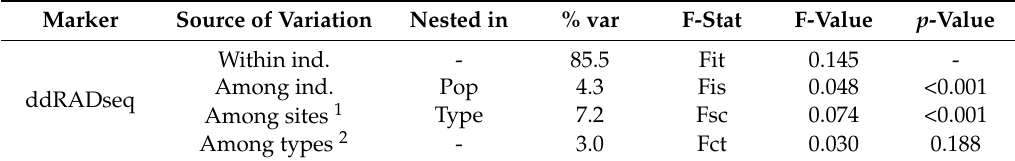
Table legend: 1 Sampling sites, 2 life history forms (ferox trout and benthivorous brown